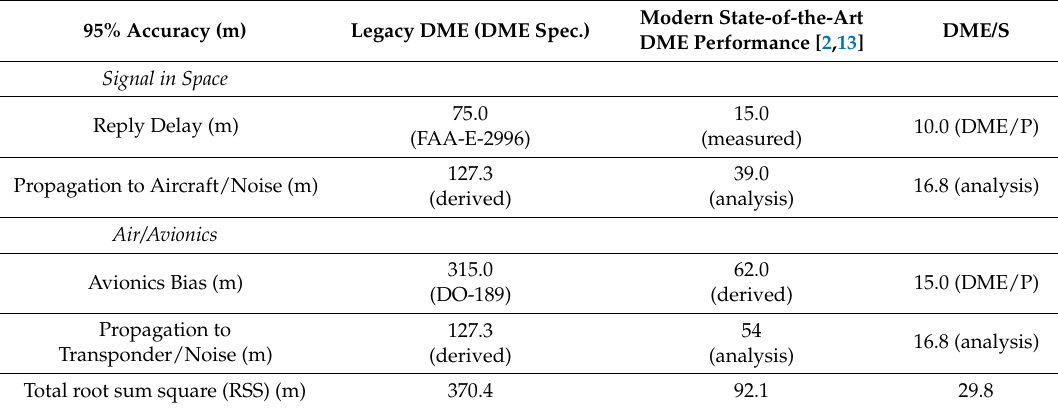
Table 1. Ranging accuracy budget of legacy DME, modern DME, and